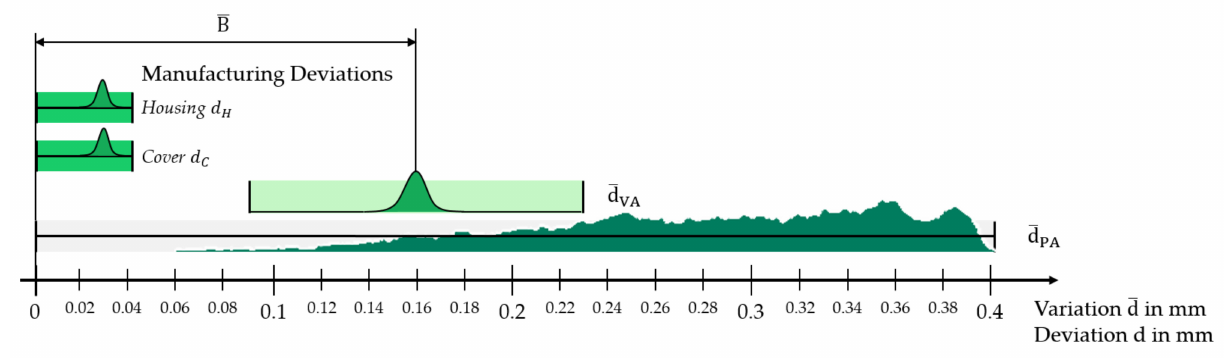
Figure 9. Comparison of virtual and physical assembly variation distributions and manufacturing deviations.